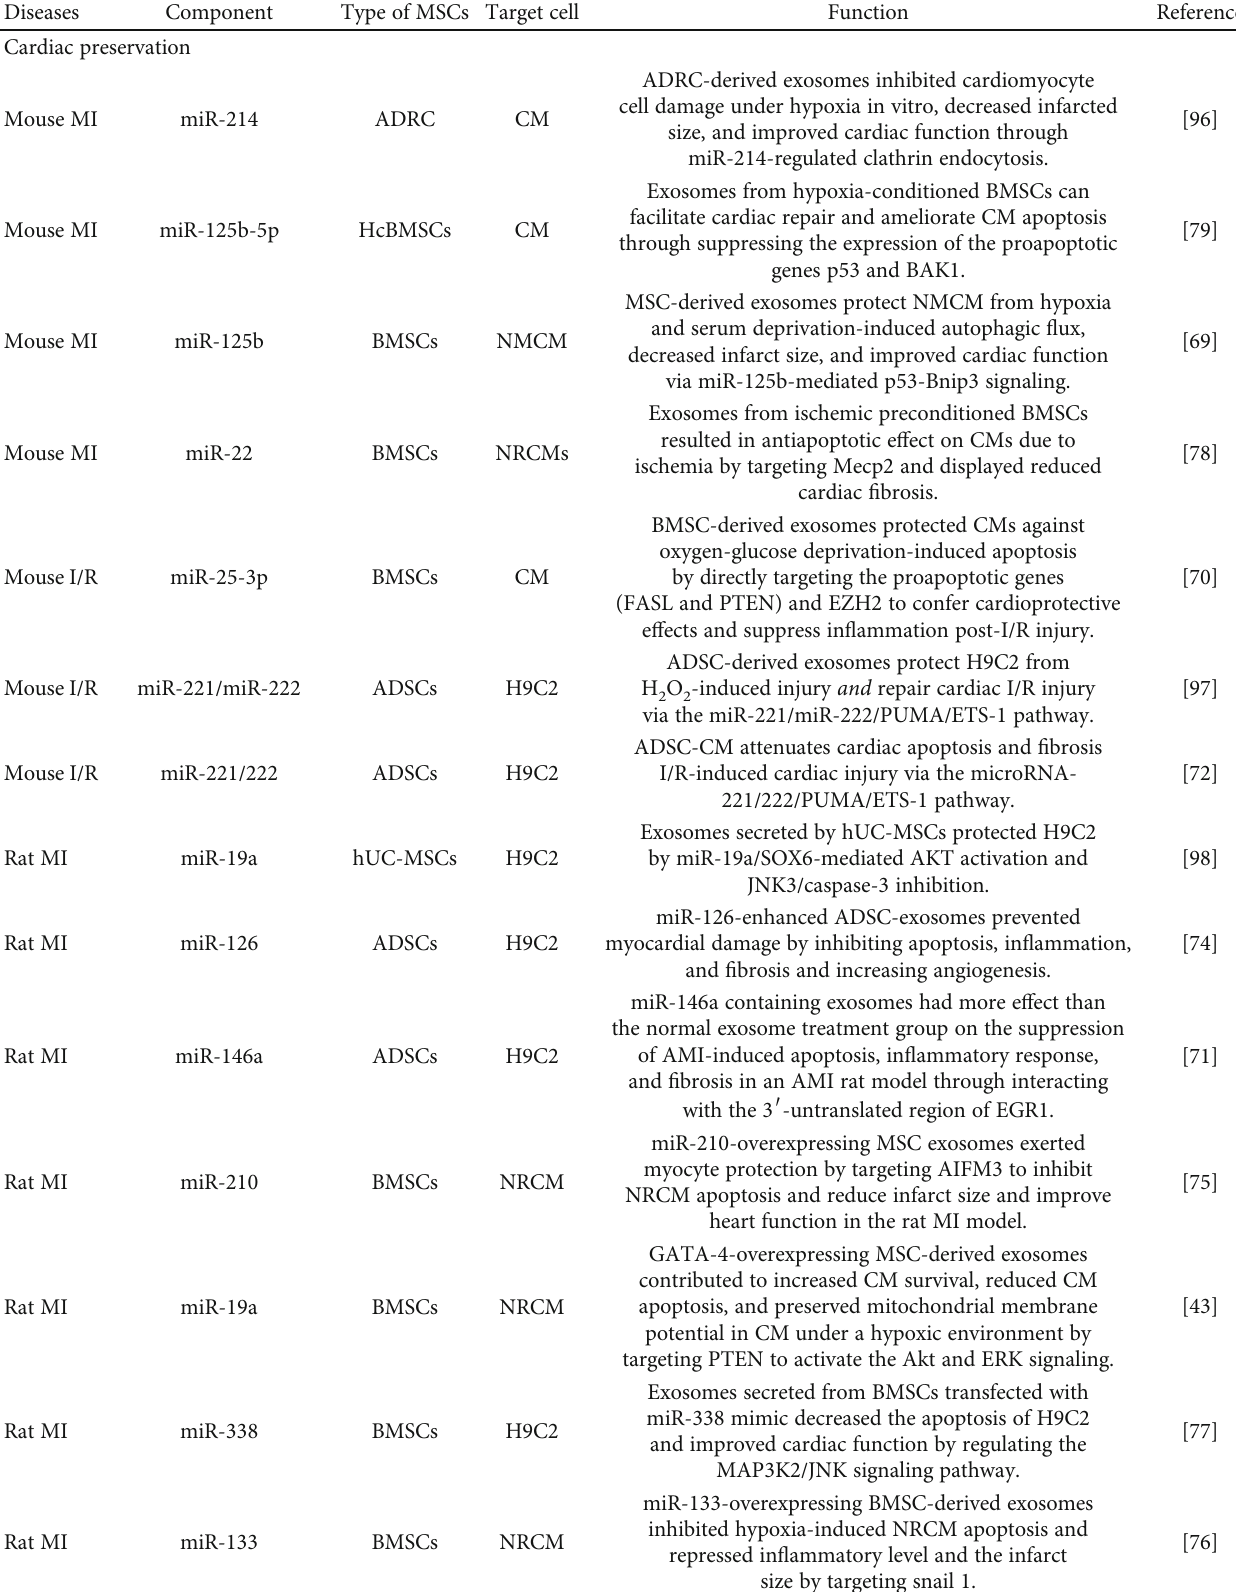
Table 1: List of components of the MSC-derived exosome molecular cargo to regulate cardiac repairment published in the recent 5 years.